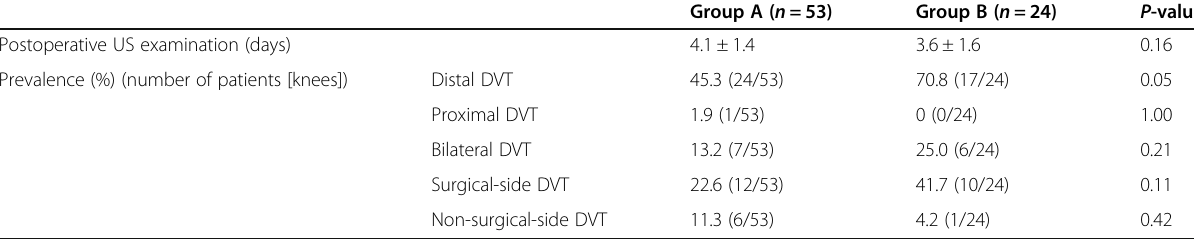
Table 4 Comparison of the incidence of DVT between groups A and